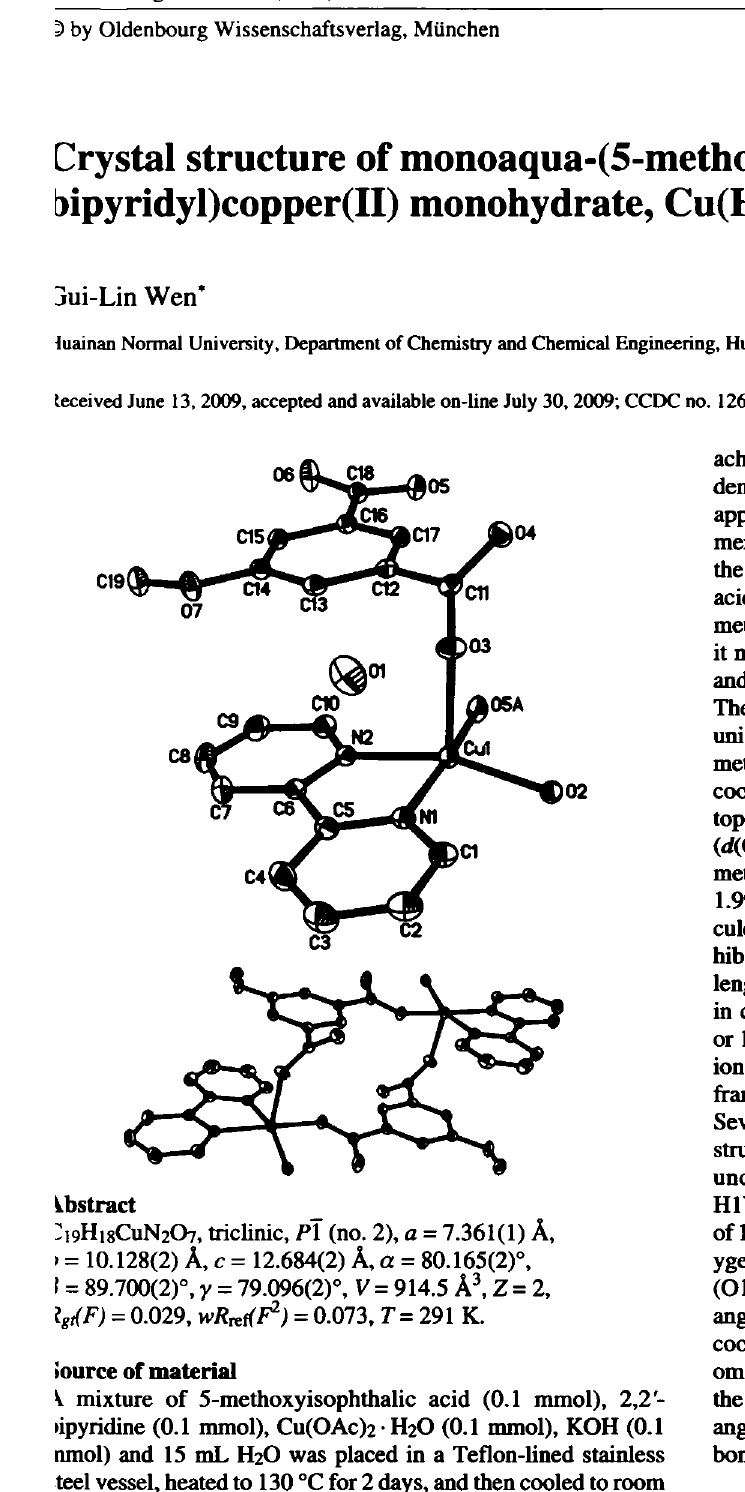
Table 1. Data collection and